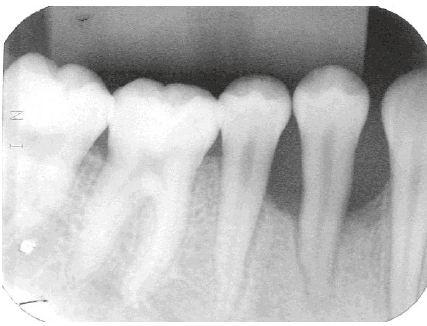
Figure 3: The radiographic image, where we can observe the extensive horizontal bone loss.